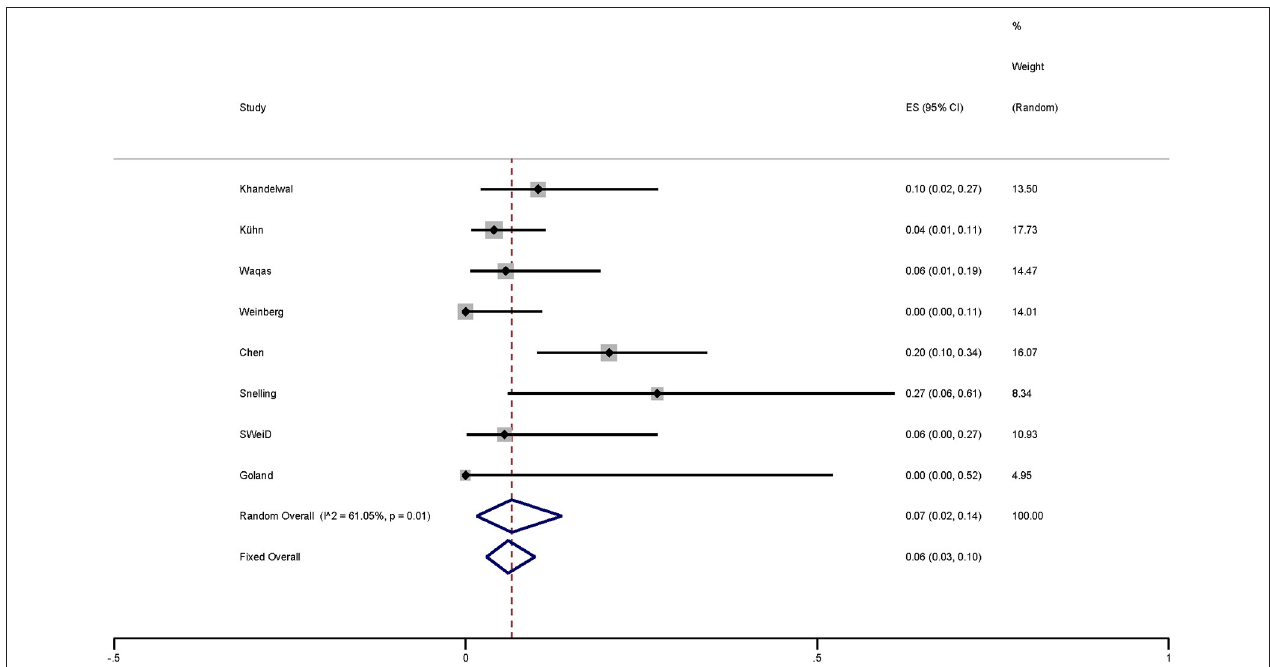
FIGURE 4 | Plot showing the from TRA to TFA of FD-treated intracranial aneurysms via TRA.